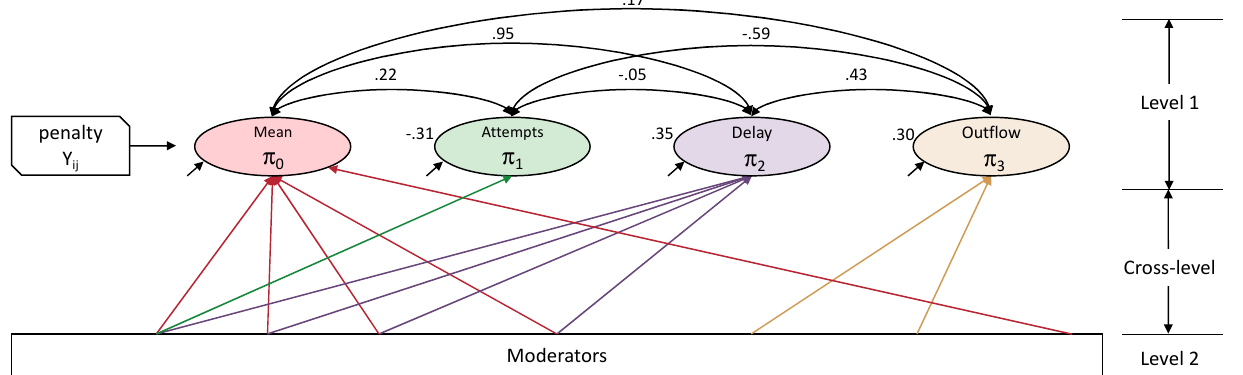
Figure 4. Intercorrelations and graphical representation of fixed-effects from MLM analysis of mi- croworld performance indexed by accumulated block penalty (adapted from Birney et al. 2018, with permission from Elsevier; ref: 5356931314753). The model was of the following general form: Level